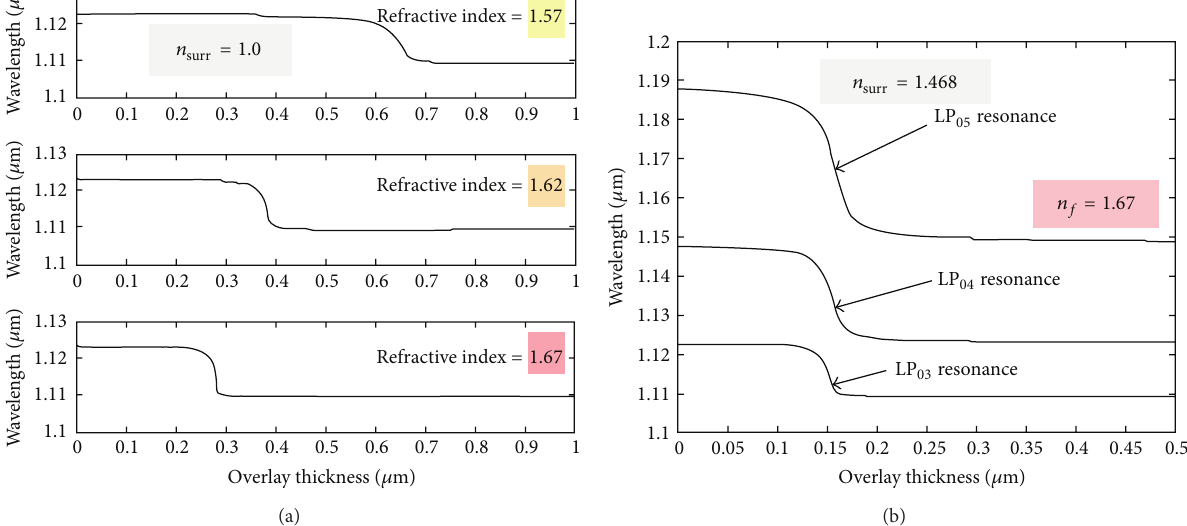
Figure 10: The transition region. (a) Dependence of the optimum thickness on the refractive index of the thin film and (b) on the surrounding refractive index (taken from